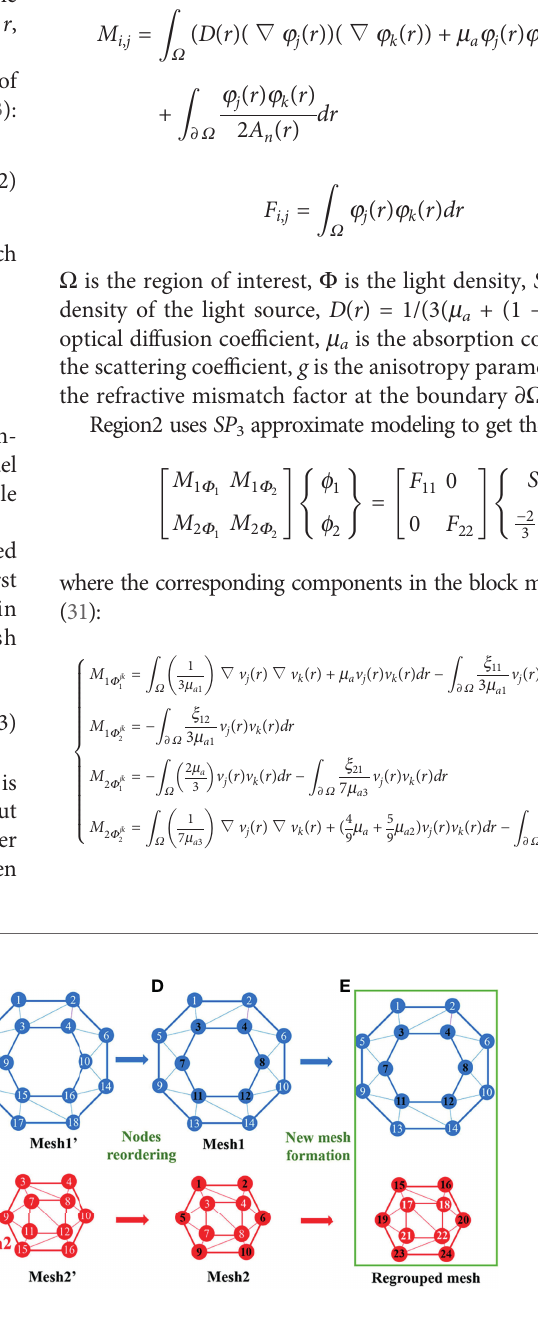
FIGURE 2 | The mesh regrouping process in simpli fi ed 2D